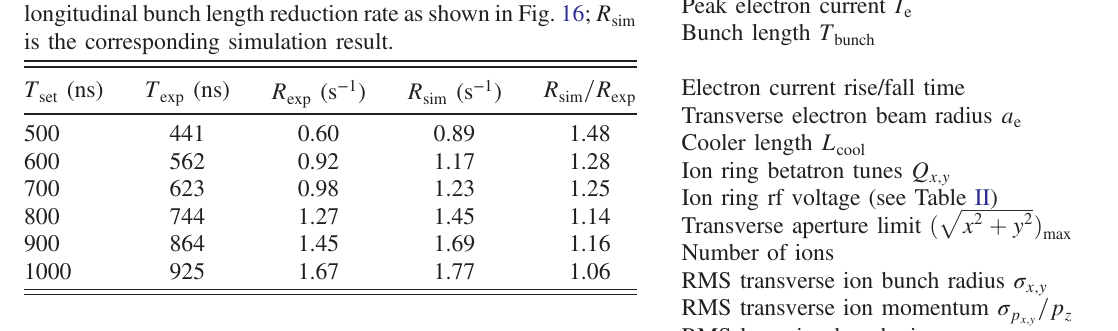
TABLE VI. Parameters for tracking simulations and theoretical estimates. and T are the nominal set exp is the exp sim